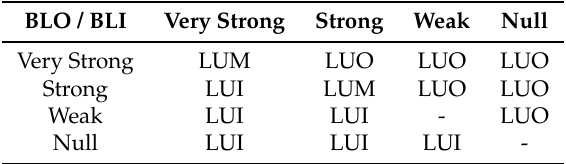
Table 1. Fuzzy Associative Memory